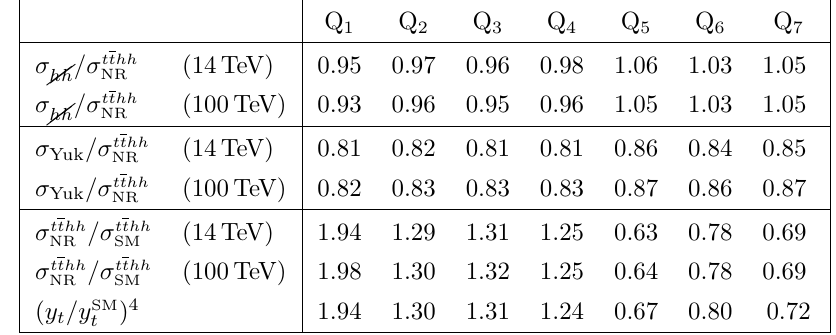
Table 4 . Study of NR- tthh for the MCHM 14 points in table 2. The cross sections σ (cid:26)(cid:26) obtained by disregarding the classes of diagrams shown on table 3 and σ The LO SM tthh production is indicated by σ SM and σ SM Higgs coupling. The top Yukawa couplings are indicated by y t and y SM